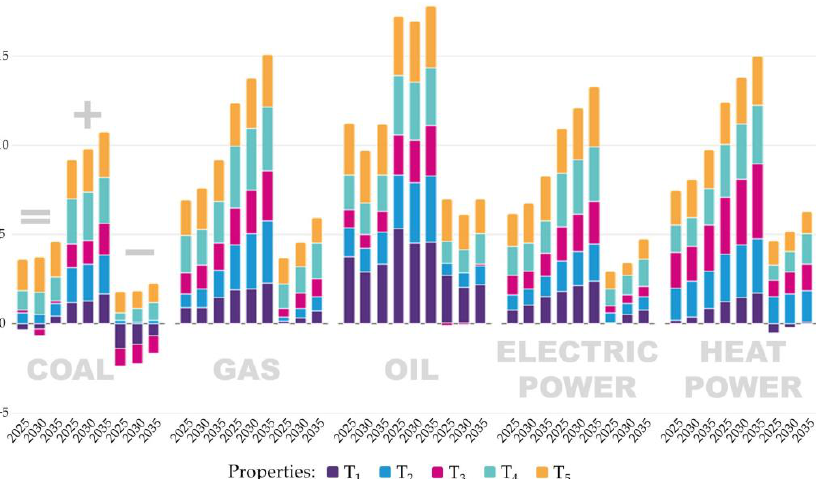
Figure 6. Industry’s scenario coefficients of the development of properties of the Southern LFEC at three time intervals.